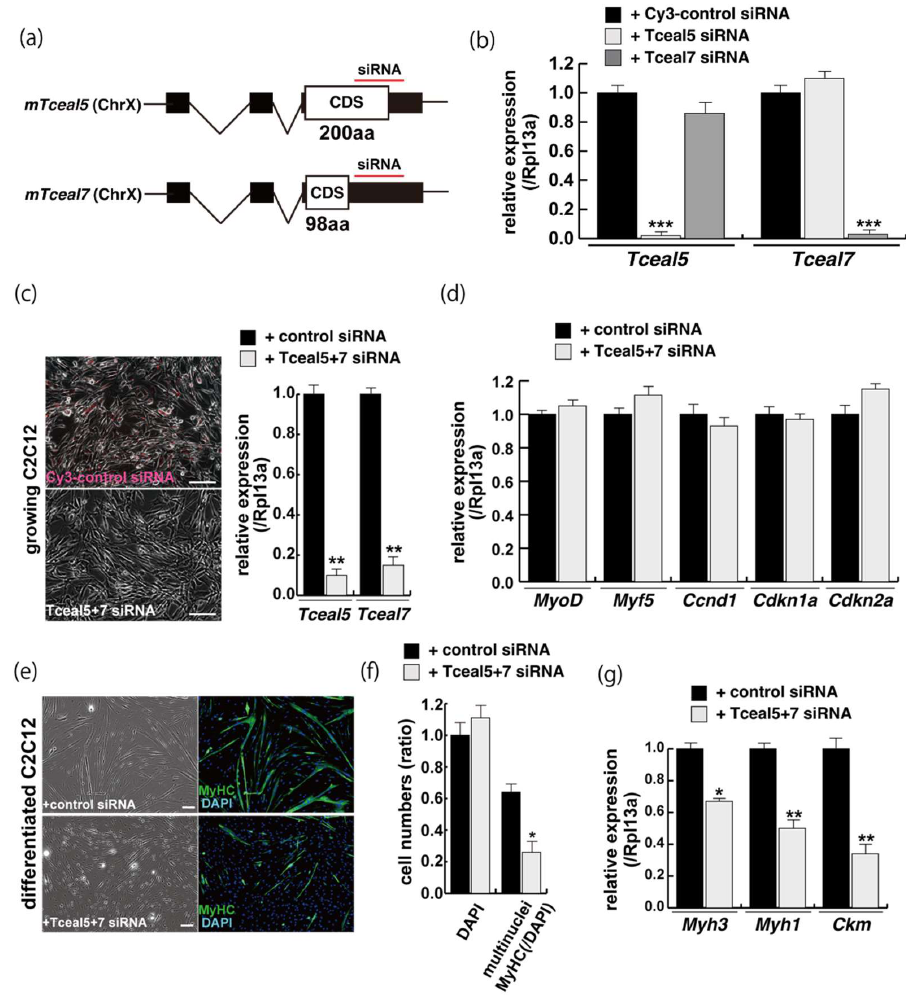
Figure 4. Downregulation of Tceal5/7 reduced myogenic differentiation. ( a ) Schematic representation of mouse Tceal5 (mTceal5, coding sequence; 200 amino acids) and Tceal7 (mTceal7, coding sequence; 98 amino acids) on chromosome X (ChrX); ( b ) RT-qPCR analyses after siRNA transfection into C2C12 cells. Each siRNA represses transcripts from the targeted gene specifically; ( c ) morphological features with both Tceal5 and Tceal7 siRNA treatment in growing C2C12 cells. Cy3-labelled siRNA was used as a control (left). RT-qPCR analyses after both siRNAs transfection into C2C12 cells (right). ( d ) Relative RT-qPCR analyses of myogenic determination (MyoD, Myf5) and cell cycle genes (Ccnd1, Cdkn1a, Cdkn2a) in growing C2C12 cells with or without both siRNAs; ( e ) differentiated C2C12 cells with siRNAs were immunostained with anti-MF20 (MyHC, green). All nuclei were stained with 4′6-diamidino-2-phenylindole (DAPI, blue); ( f ) relative cell numbers of differentiated C2C12 cells with or without Tceal5/7 siRNAs, counted with anti-MyHC antibody and DAPI in ( e ); ( g ) relative RT-qPCR of mature myogenic transcripts (Myh1, Myh3, Ckm) in differentiating muscle cells with or without Tceal5/7 siRNAs; All Scale bar = 100 μm. Data represent means ± SEM ( n = 3). The statistical analysis was performed by Mann–Whitney U test. * p < 0.05, ** p < 0.01, *** p < 0.001.